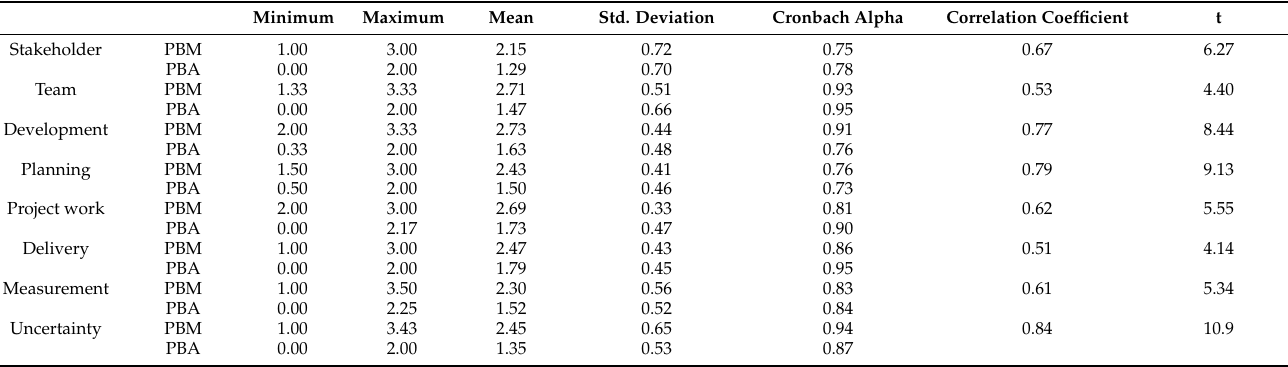
Table 5. Descriptive statistics, Cronbach’s alpha, and correlation